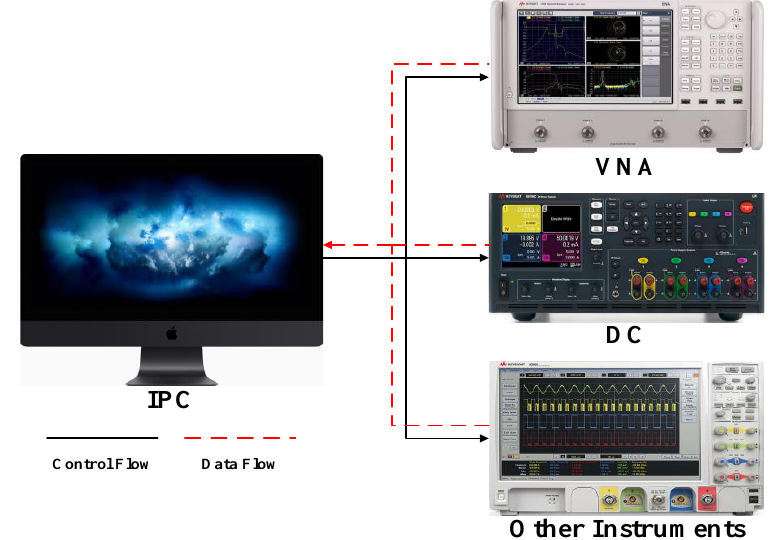
Figure 13. The former distribution mode.